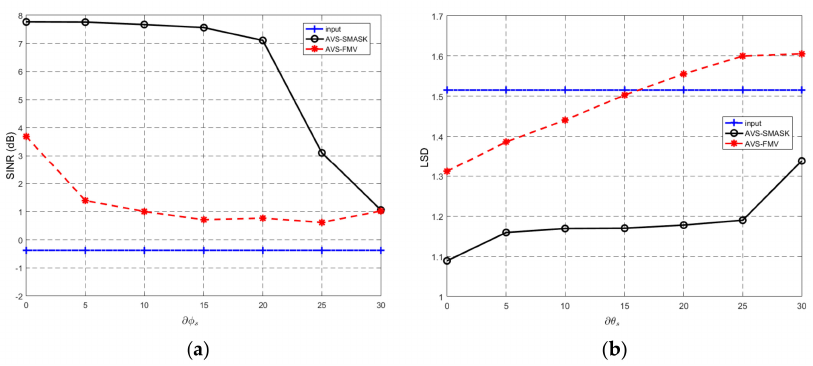
Figure 9. (Experiment 3, Case 2) The performance versus the ∂θ s . ( a ) SINR results and ( b ) LSD results (Case 2).